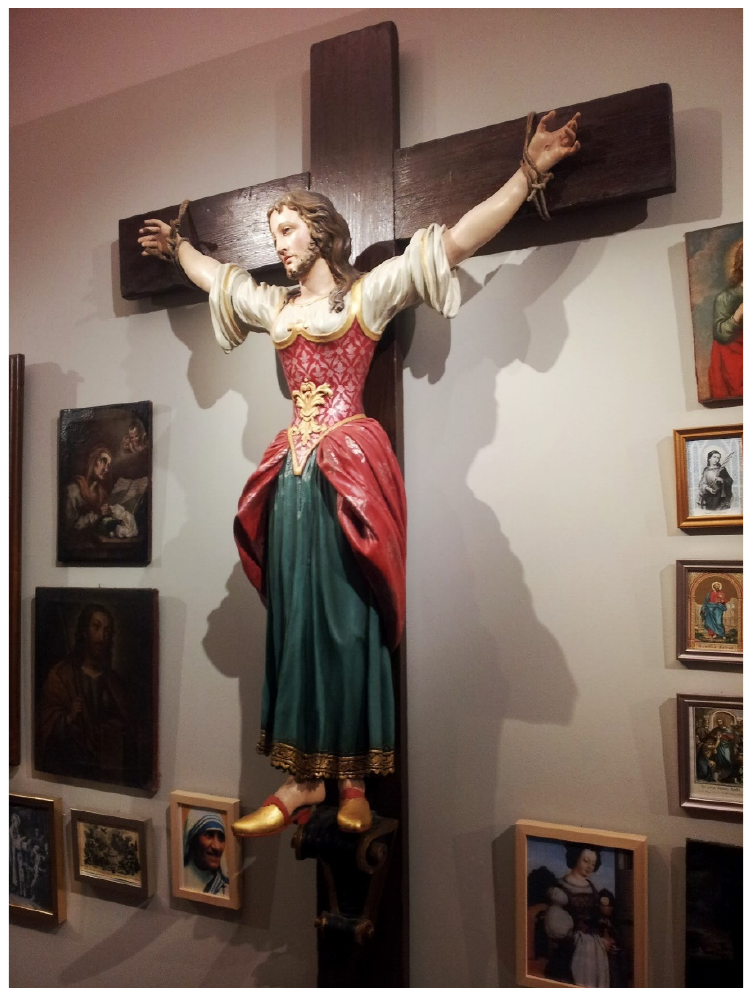
Figure 3. Saint Wilgefortis (18th c.), Diocesan Museum of Graz, Austria. Photo Credit: Gugganij, own work, CC BY-SA 3.0, https://commons.wikimedia.org/w/index.php?curid=27324725 (accessed on 29 May 2022).